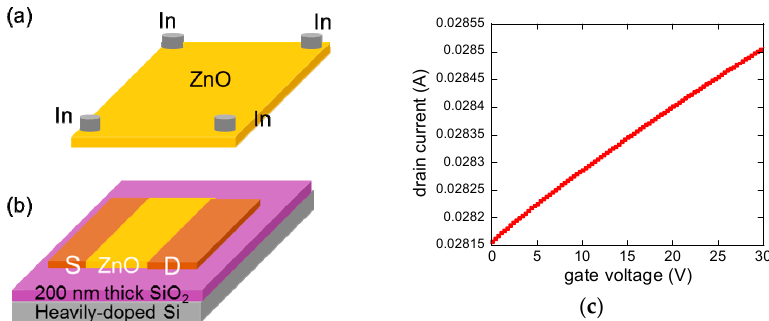
Figure 1. Electrical properties of Al-doped ZnO films. ( a ) Schematic of a Hall effect measurement device. Indium contacts are spaced by ~5 mm. Applied current is 2 mA. ( b ) ZnO field effect transistor (FET) devices to measure the FET mobility. The thickness of ZnO is ~90 nm. The source and drain electrodes (Au/Ti) are 80 nm thick. ( c ) Transfer characteristic curve of a ZnO FET. The drain current was fixed at 5 V.